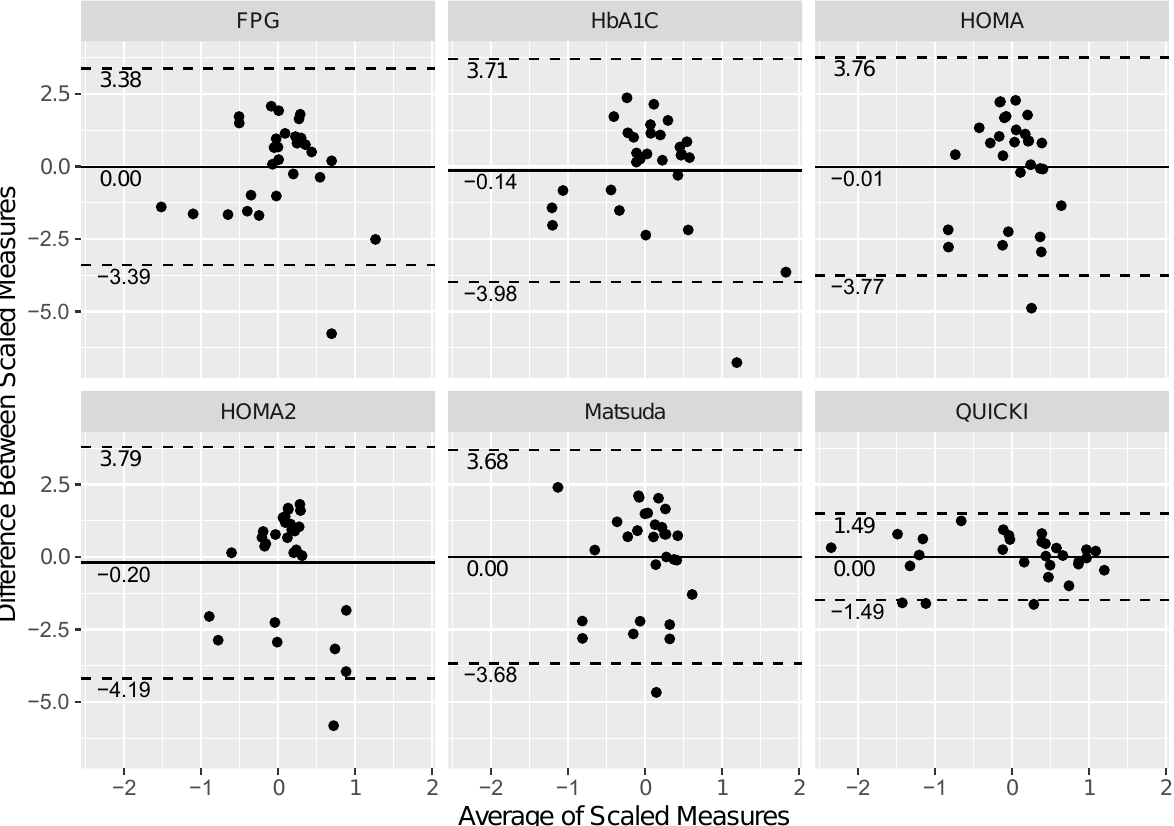
Figure 1. Bland–Altman plots measuring the level of agreement against the scaled, log-transformed Si value and fasting plasma glucose (FPG), hemoglobin A1C (HbA1cC), Homeostatic Model Assessment for Insulin Resistance (HOMA), HOMA2, Matsuda Index, and Quantitative Insulin-sensitivity Check Index (QUICKI). Each data point corresponds to the measurement of 29 participants on Si and the six indices. The solid line represents the mean of the scaled, log-transformed mean difference between two measurements (Si and index), whereas the dashed lines represent the 95% confidence intervals (mean ± 2 standard deviations above and below the mean difference).